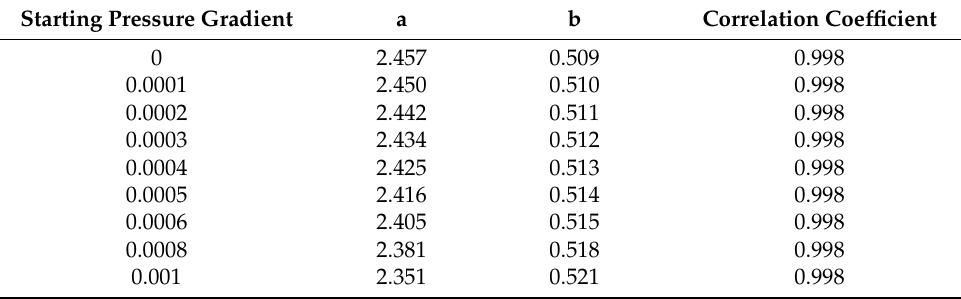
Figure 7. Relationship between exponent b and the starting pressure gradient. Table 4. Comparison of calculating results under a closed